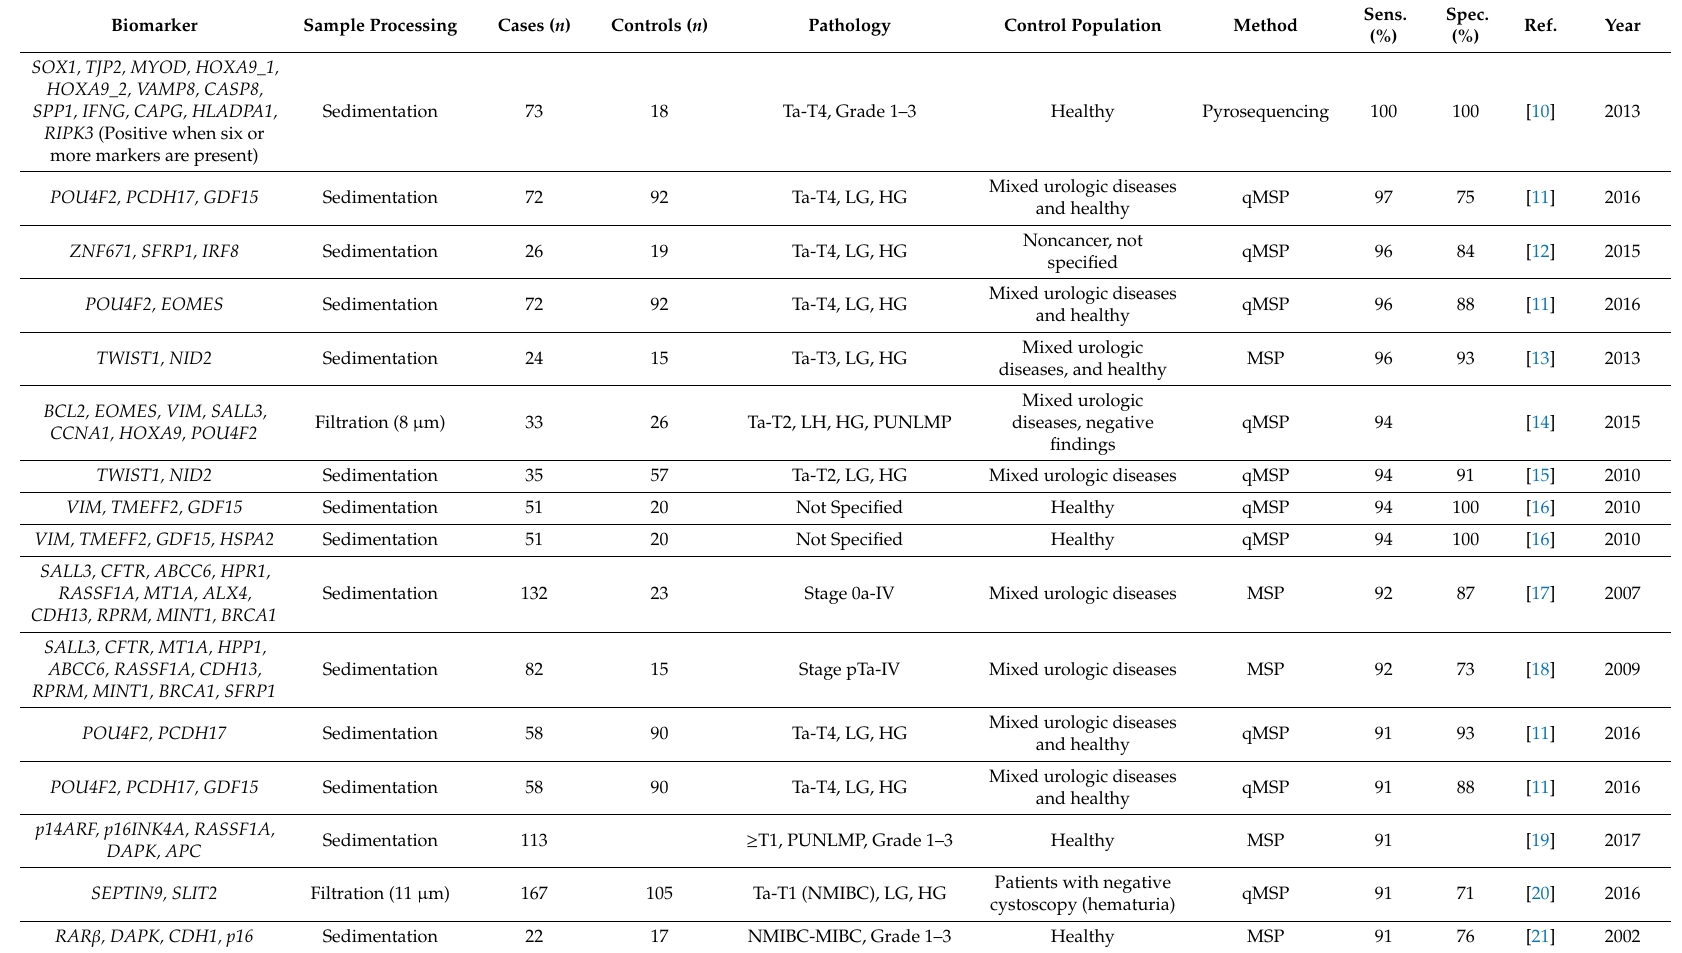
Table 1. DNA-methylation biomarker panels for detection of primary bladder